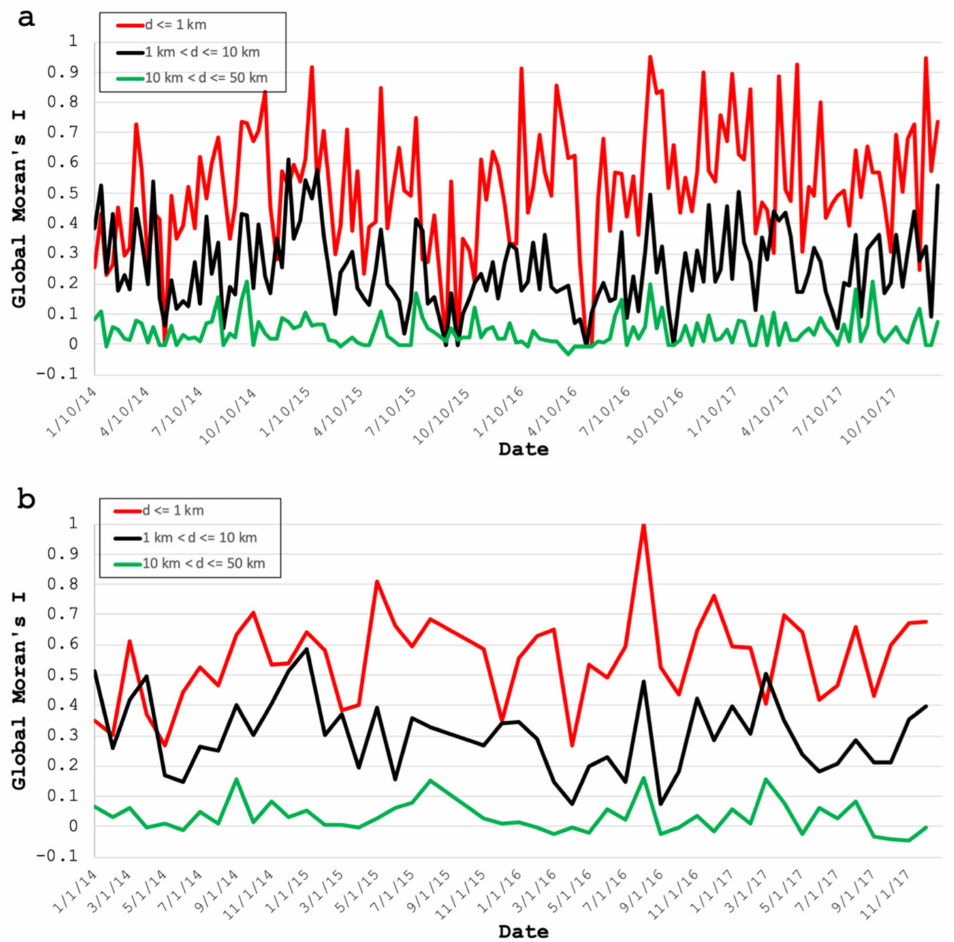
Figure 5. Global Moran’s I obtained for each ( a ) 10 day period and ( b ) month in the study period using all ARGs and synoptic rainfall measurements in the